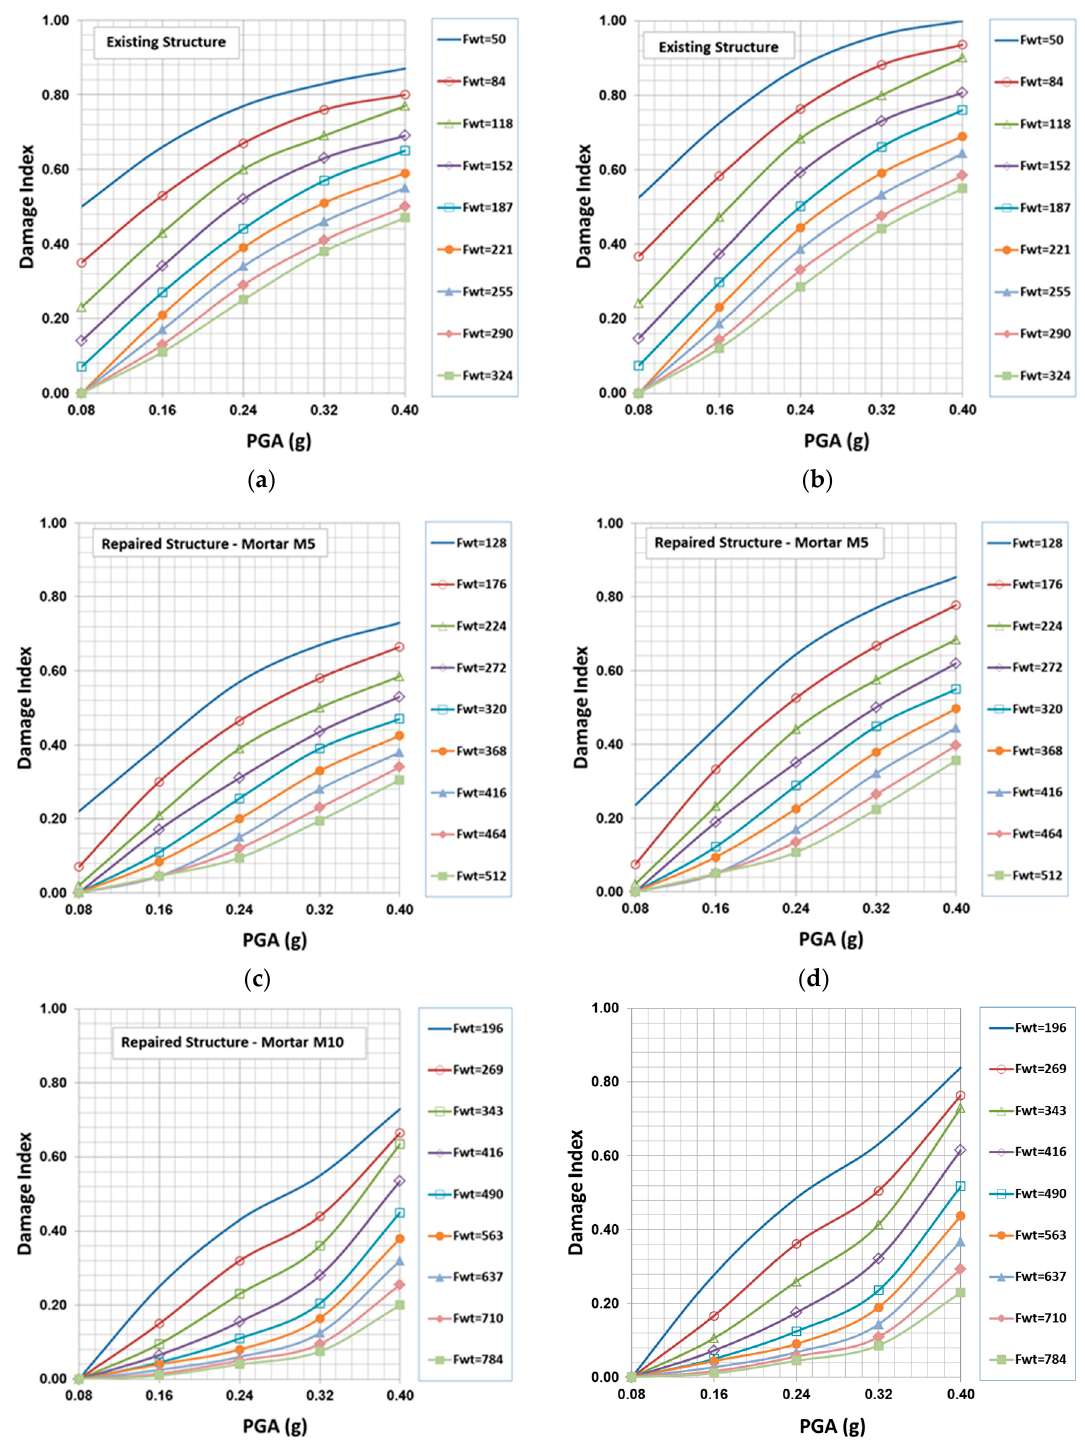
Figure 11. Damage indices for the existing, as well as for the two case of repaired structure with M5